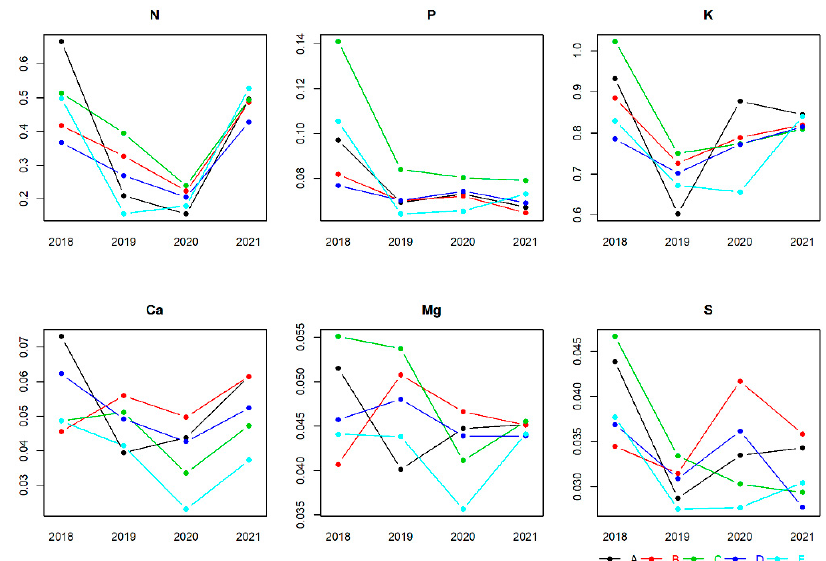
Figure 3. Each plot refers to a nutrient in fruits 15 DBH. Each point represents the average of 9 values (3 biological replicates for each of the 3 fertilization strategies) observed for a given year and orchard (%). Lines connect observations from the same orchard.